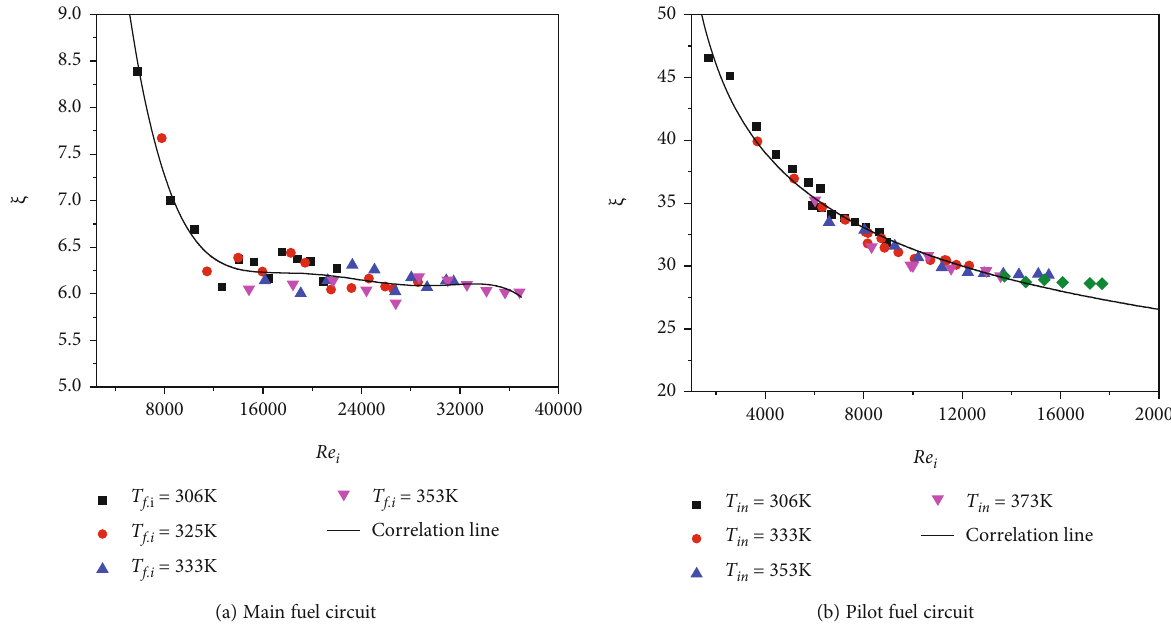
Figure 20: Comparison of correlation and measured data.